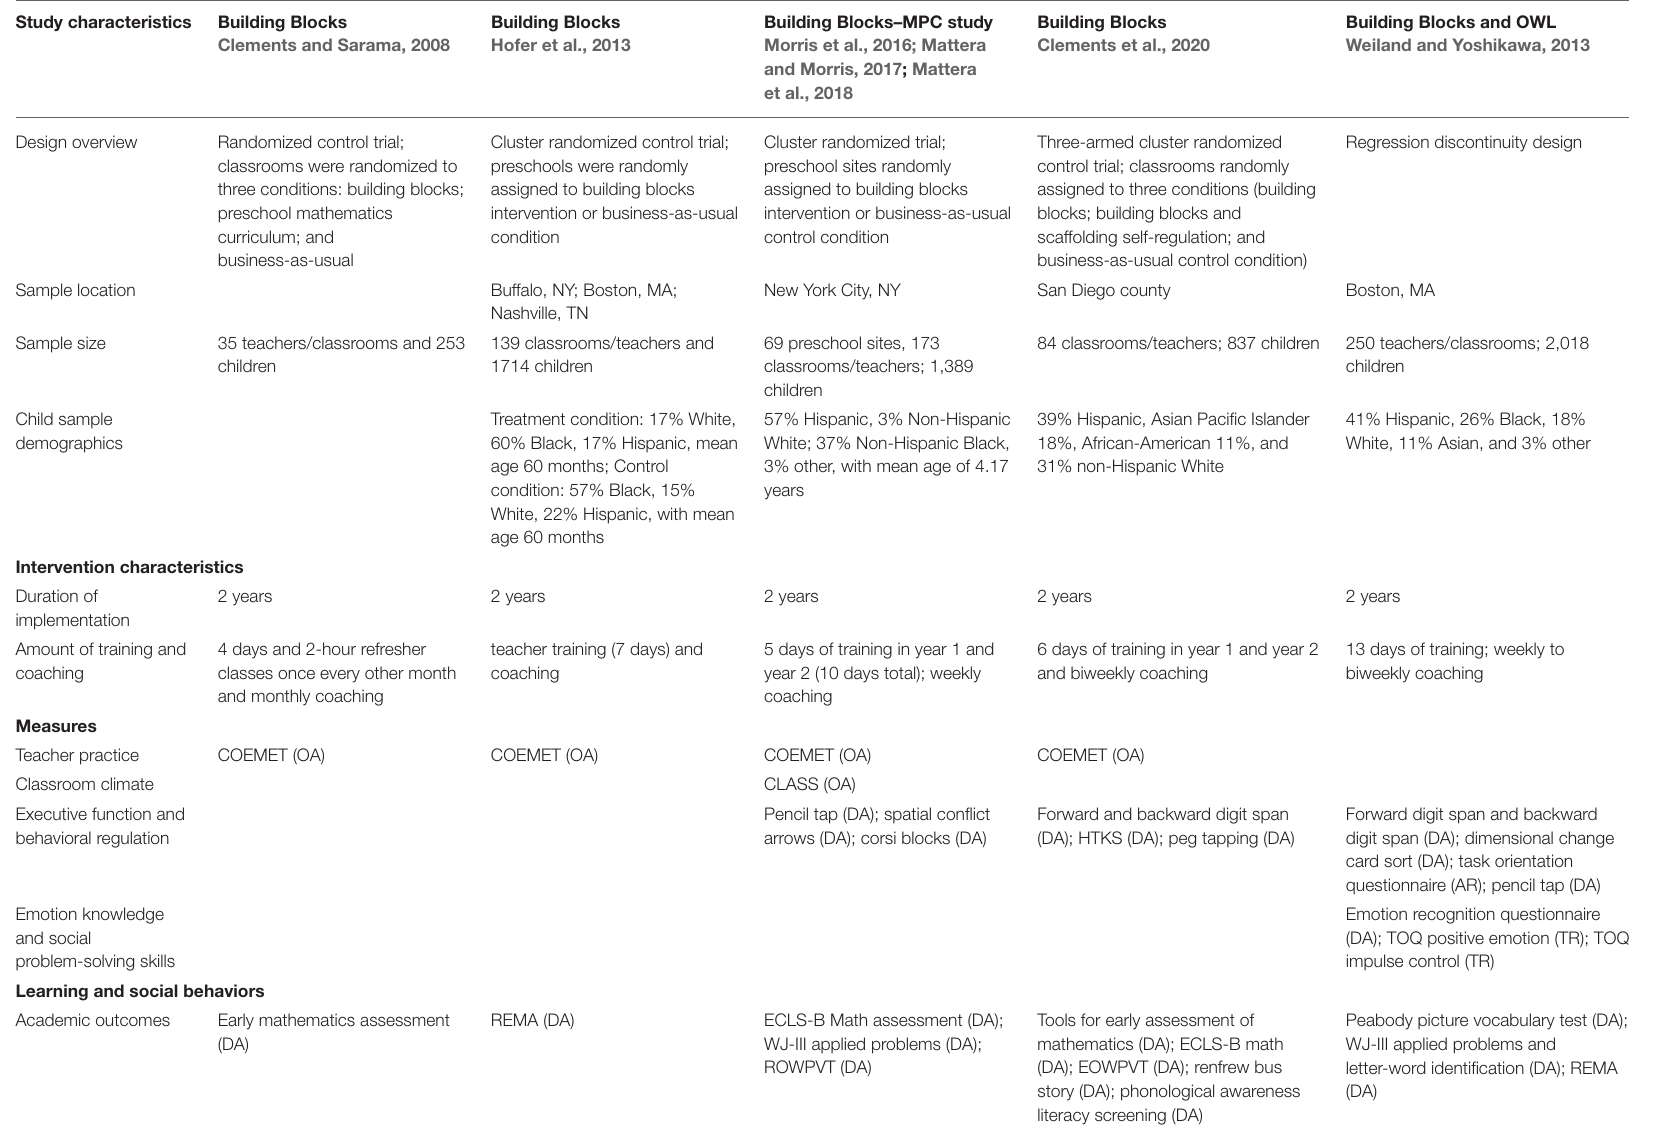
TABLE 4 | Background characteristics of the cognitive skills